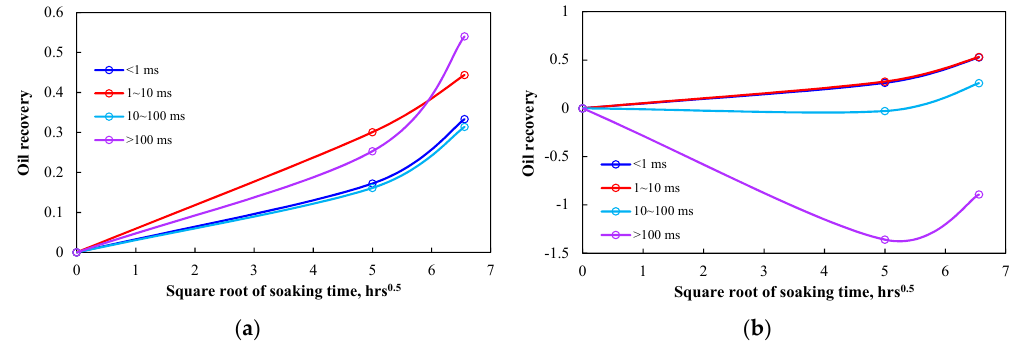
Figure 17. Oil recovery in different diameter pores: ( a ) WEH-1 and ( b ) WEH-2.